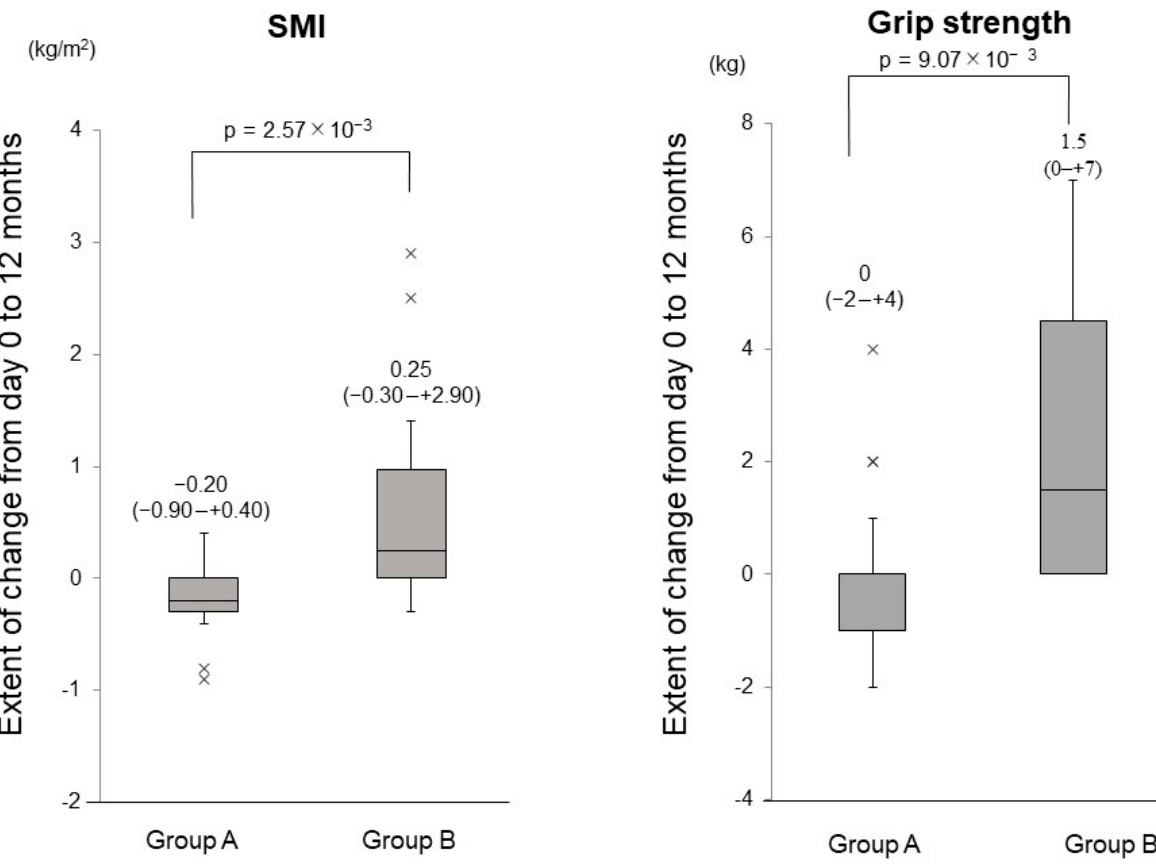
Figure 4. The extent of changes in the skeletal muscle mass index (SMI) and grip strength between day 0 and 12 months in the untreated (Group A) and vitamin D-treated (Group B) patients.